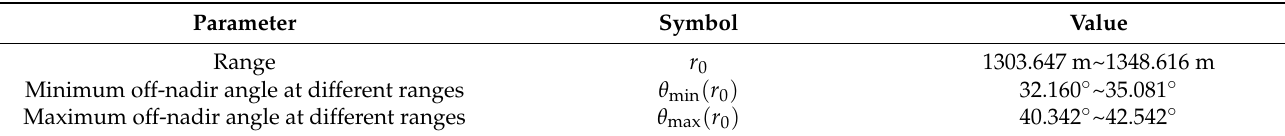
Figure 21. The selected region in experiment 2: ( a ) the configuration of the antenna array. The 2-D SAR image of the measured data: ( b ) the whole scene and ( c ) the inversion area in the green frame in ( b ). Table 7. Parameters of the selected region in experiment 2.